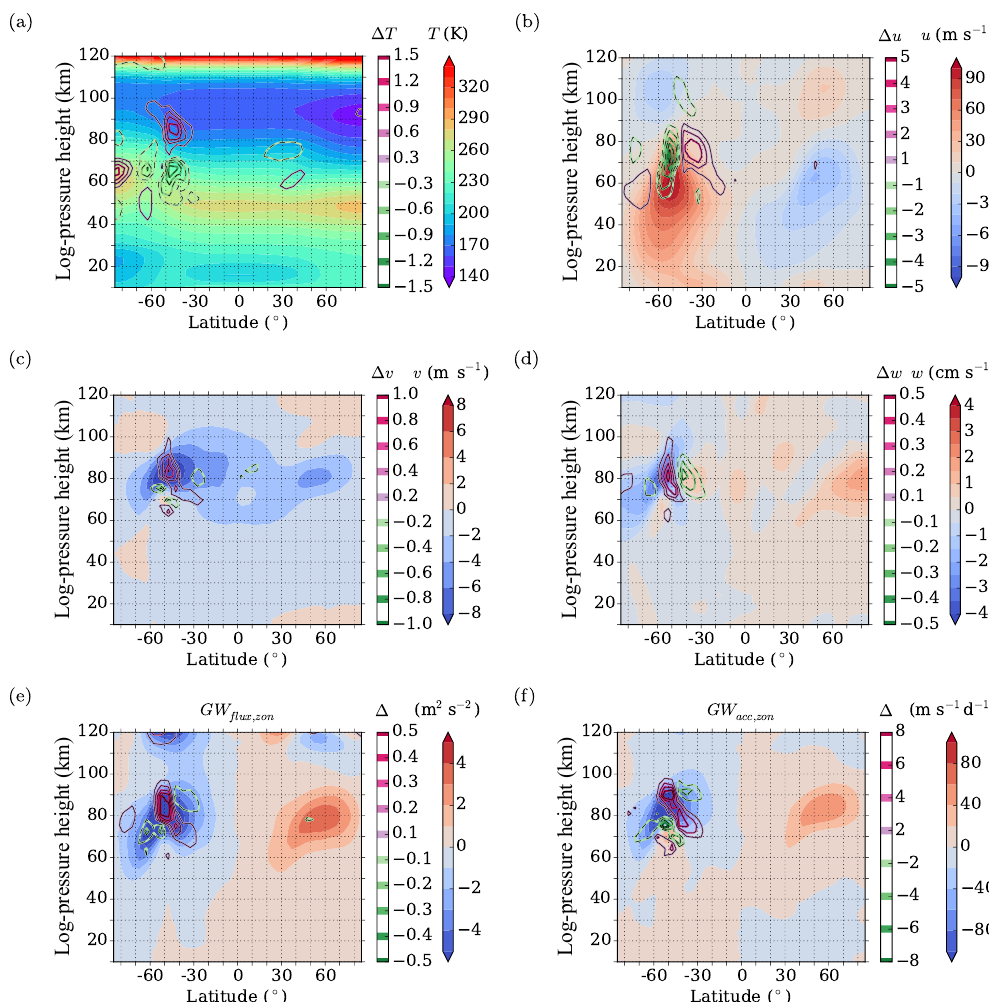
Figure 2. Background colors: Run1 zonal mean parameters for (a) temperature, (b) zonal wind, (c) meridional wind, (d) vertical wind, (e) zonal GW momentum flux, and (f) zonal acceleration of the mean wind by GWs. Isolines: differences of these parameters for Run2– Run1. For Run1, GW weights in the GW parameterization routine have been selected as zonal means according to Fig. 1b while Run2 includes a 2-D horizontal field according to Fig. 1a..